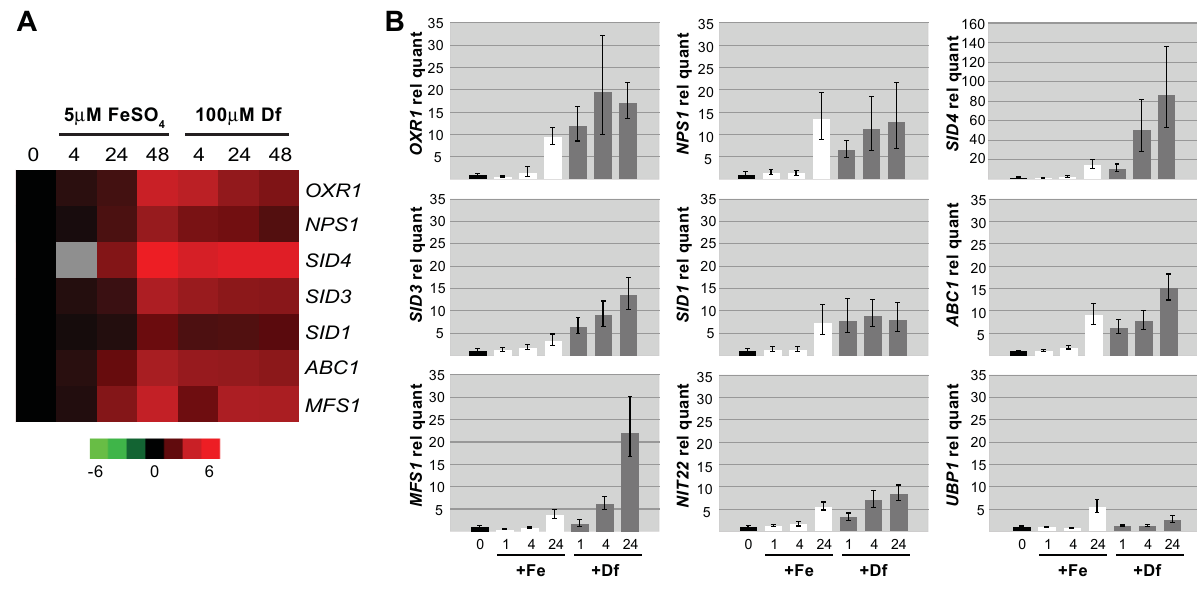
Figure 1. Iron Regulated Gene Expression of Siderophore Biosynthesis and Utilization Genes. A. Iron-dependent gene expression cluster from whole genome oligonucleotide microarray analysis of G217B yeast grown under iron replete (5 m M FeSO 4 ) and iron limited (100 m M deferoxamine mesylate) conditions for 0, 4, 24, and 48 hours, as described in Materials and Methods. Red indicates up-regulated genes, green indicates down-regulated genes, black indicates genes that do not change in expression, and gray indicates that no data are available. Microarray time courses were repeated with three biological replicates. A representative experiment is shown. Similar results were seen for iron replete conditions of either 5 or 10 m M FeSO 4 . B. Quantitative RT-PCR of siderophore biosynthesis and utilization genes. Total RNA from the 0, 1, 4, and 24 hr time points used in the microarray analysis were analyzed for relative transcript levels using QRT-PCR. Transcript levels were normalized to ACT1 transcript. Relative quantities were normalized to t=0 values (black bars). For the 1, 4, and 24 hr time points, white bars indicate growth in medium supplemented with FeSO 4 ( + Fe), and gray bars indicate growth in deferoxamine ( + Df).